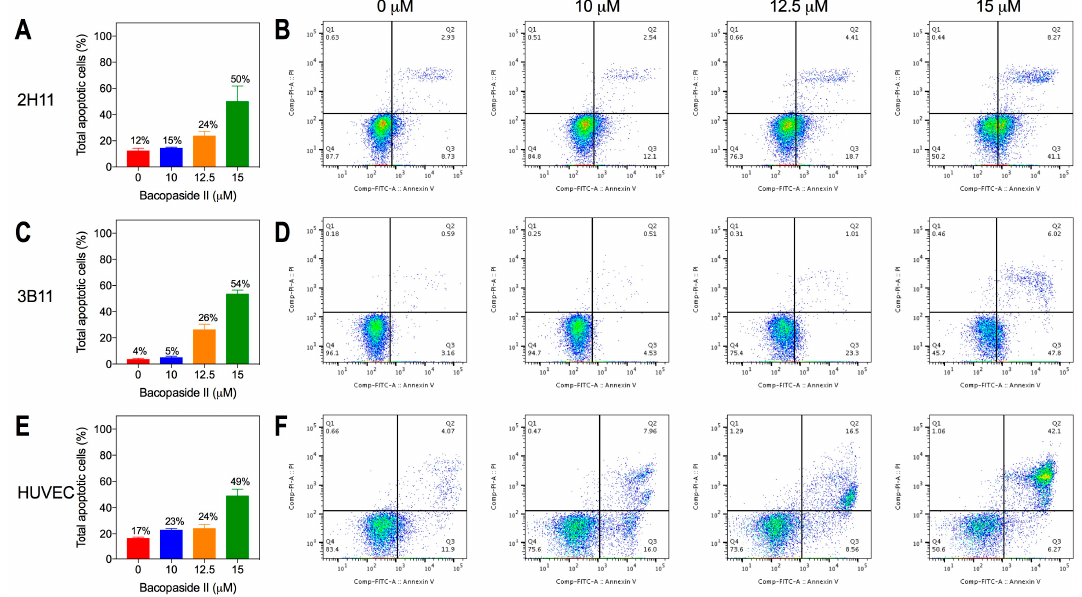
Figure 3. Bacopaside II increased endothelial cell apoptosis as determined by flow cytometry. Histograms (left) show percentages of apoptotic cells (early and late) in a representative experiment for data shown in the scatter plots at the different concentrations of bacopaside II. Results are shown for 2H11 ( A , B ), 3B11 ( C , D ) and HUVEC ( E , F ). In ( A , C , E ), results shown as the mean ± SD; in ( B , D , F ), scatter plots show population gates of viable cells (left lower quadrant), or cells either in early apoptosis (right lower quadrant), late apoptosis (right upper quadrant), or necrosis (left upper quadrant).